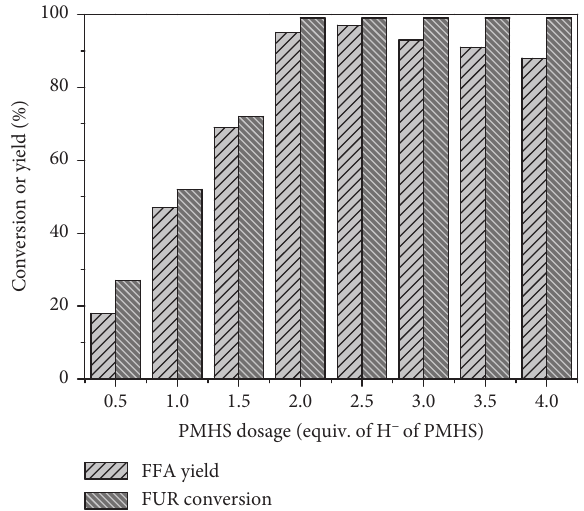
Figure 7: Effect of PMHS dosage on the reduction of FUR to FFA. Reaction conditions: 0.5mmol FUR, 25 mg 5wt.% KF/ZrO 2 , 2mL DMF, 25 ° C, and